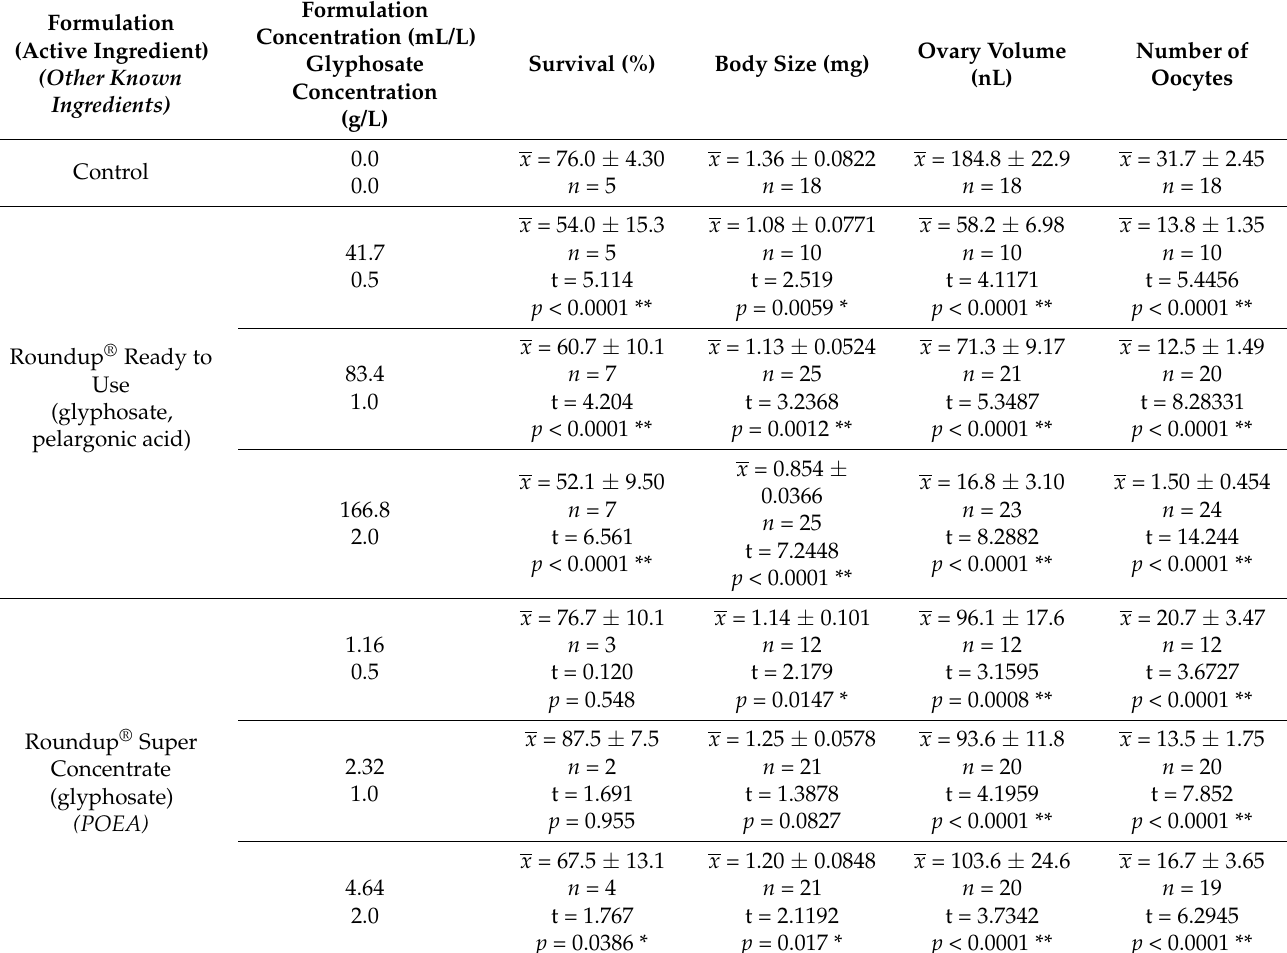
Table 2. Average percent survival, body weight, ovary volume, and number of oocytes of D. melanogaster females exposed to organic control medium or herbicide treatment within 2 h of eclosion for 7 days ( ± std. error). Results of t -tests indicating which points are significantly different from the control. * p -values < 0.05, ** p -values < 0.002, the Bonferoni-corrected p -value for 24 t -tests. Active ingredients are shown in parentheses. Other known ingredients are shown in parentheses and